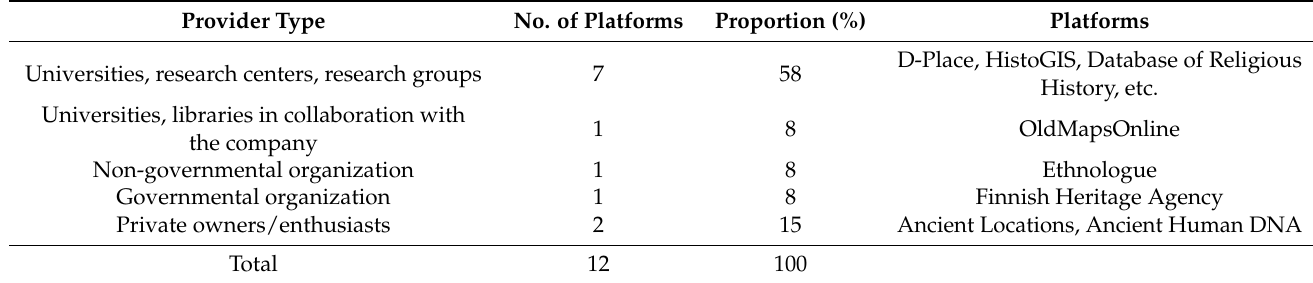
Table 2. Providers, i.e., owners, developers, and coordinators of the historical spatial data platforms in our review. Provider Type